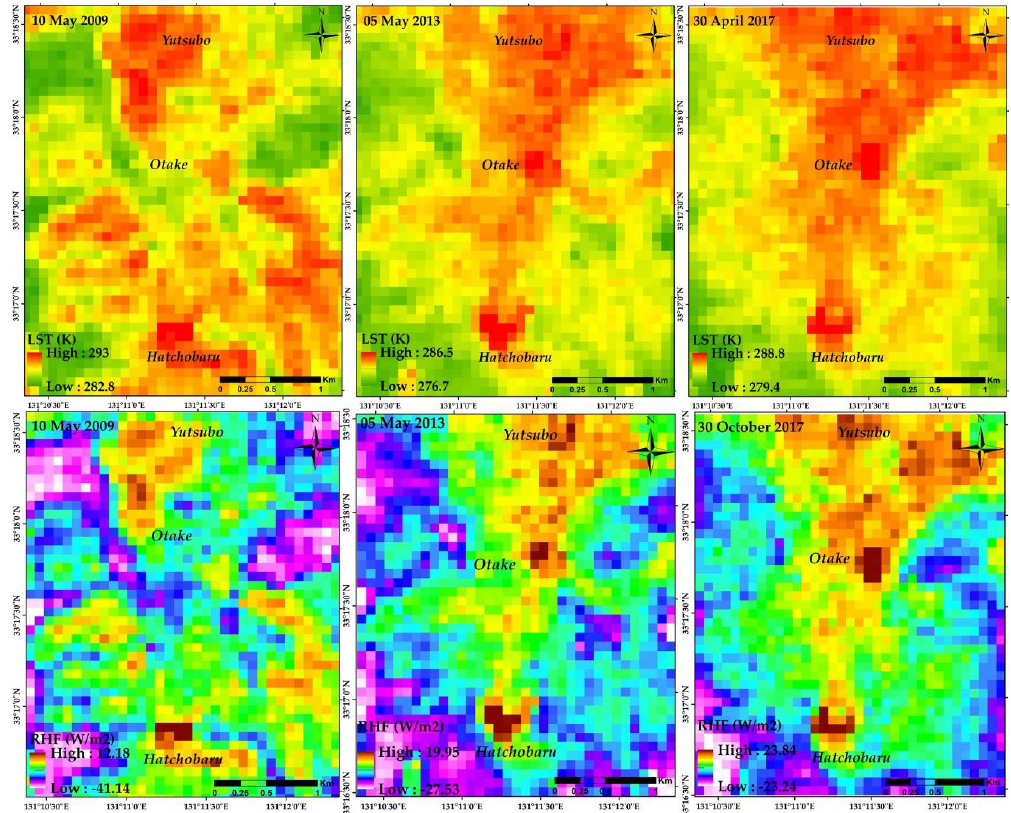
Figure 9 . High level ASTER standard product of the surface kinetic temperature (AST_08) of the HO geothermal area for the year of 2009, 2013, and 2017 (( top ) row). RHFs are shown in the ( bottom ) row, retrieved from the ASTER standard products of surface emissivity (AST_05) and surface kinetic temperature (AST_08) of the study area for the year of 2009, 2013 and 2017.